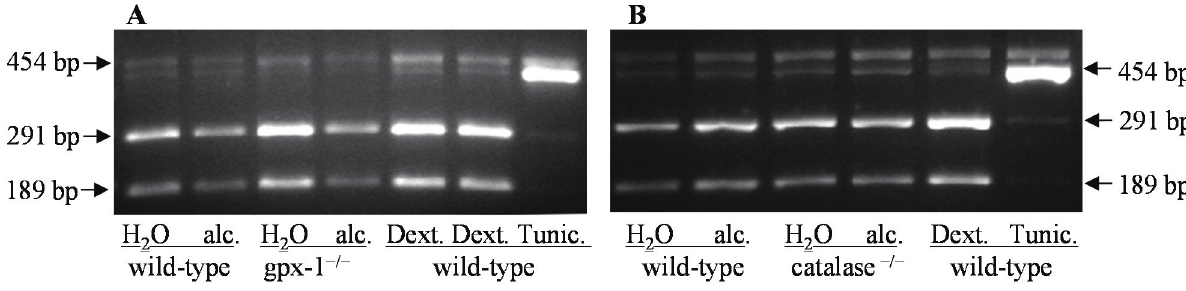
Figure 5. XBP1 mRNA splicing in the livers of H 2 O or ethanol (alc.)-fed wild-type and catalase (cid:2)/(cid:2) or gpx-1 (cid:2)/(cid:2) transgenic mice was determined by RT-PCR and Pst1 restriction enzyme digestion. Wild-type mice injected with dextrose as control (Dext.) or tunicamycin (Tunic.) were used as controls. 454 bp, and 291bp and 189 bp amplicons refer to spliced (Pst1-resistant) and unspliced XBP1,